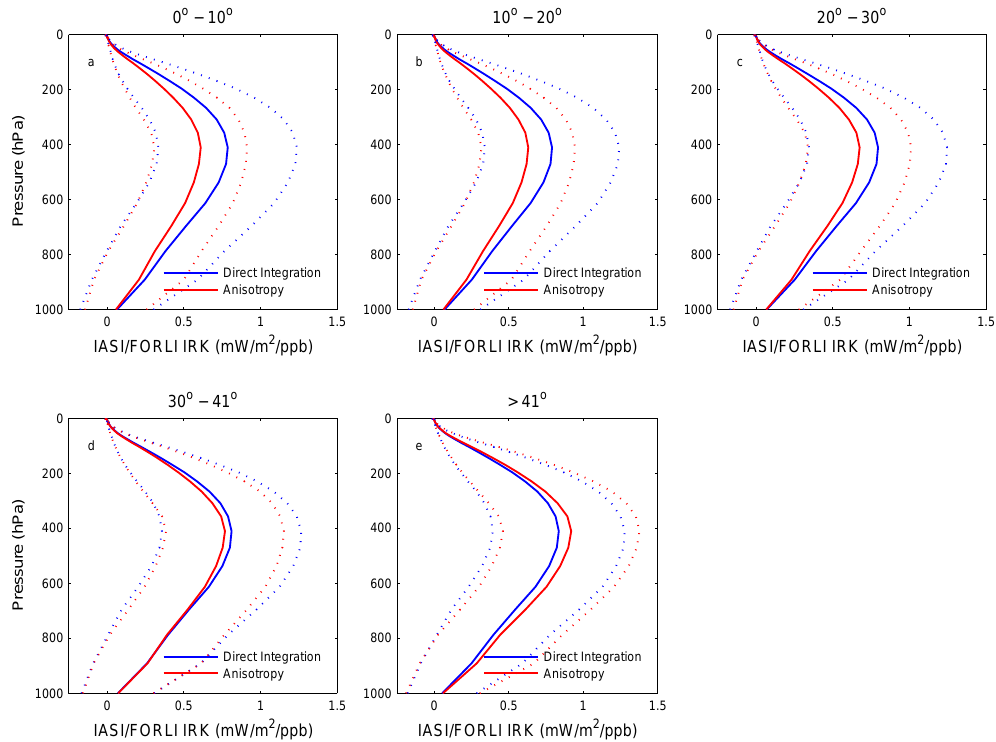
Figure 2. Global average clear-sky ozone IRK profiles as computed via the anisotropy approximation (red line) and the direct integration (blue line) on 15 April 2011. The dashed lines indicate ± 1 σ standard deviations with the same color index. The averages were calculated in bins of 10 ◦ of nadir viewing angle, from 0 to 30 ◦ (a – c) , 30 to 41 ◦ (d) and for angles larger than 41 ◦ to maximum 48.3 ◦ (e) for